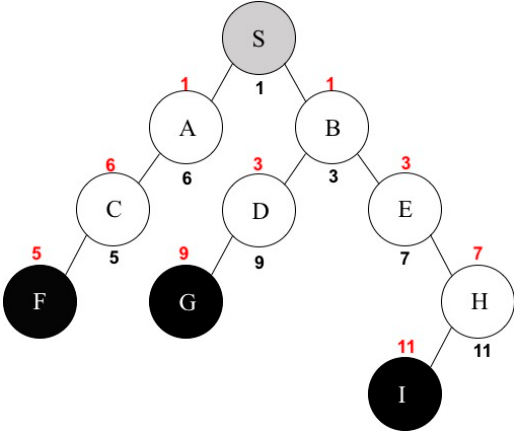
Figure 3. Channel assignment example by MICA.